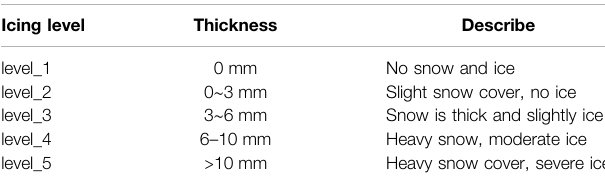
TABLE 3 | Classi fi cation of insulator icing